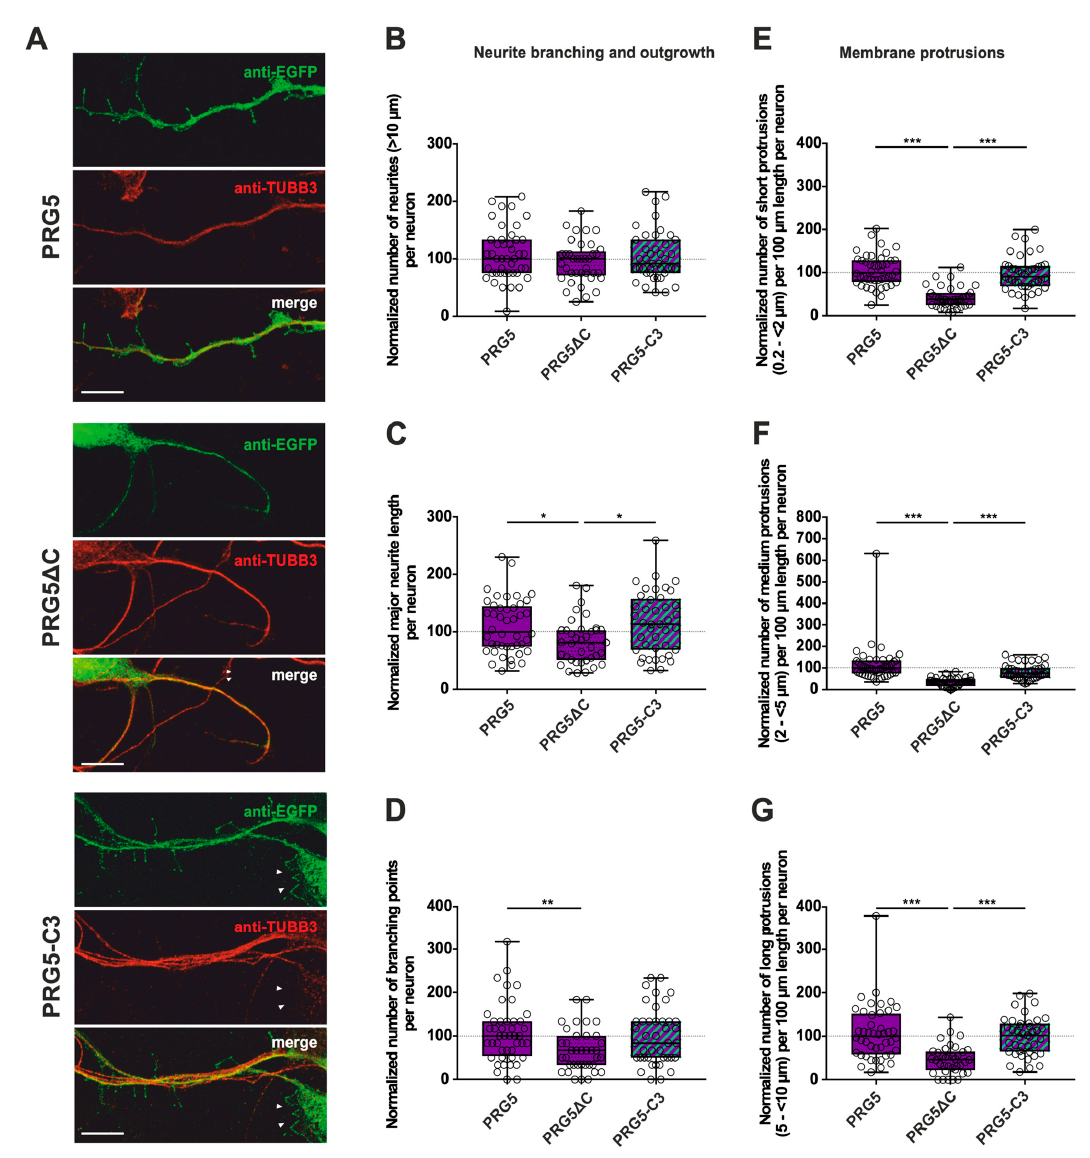
Figure 4. The PRG5 C-terminal domain is an important player in the early development of hippocampal neurons. Subcellular distribution of PRG5-, PRG5 ∆ C- and PRG5-C3-encoding fusion proteins in immature, primary hippocampal neurons in culture. Hippocampal neurons in culture were transfected at DIV1 with ( A ) either PRG5- (upper panel), PRG5 ∆ C- (middle panel), or PRG5-C3-encoding plasmids (lower panel), and analyzed at DIV2. Confocal stacks of representative neurons with immunocytochemistry of the respective fusion proteins stained for GFP to visualize the morphology of the cell or tubulin are shown. Arrowheads denote areas showing membrane localization. The scale bar represents 10 µ m. Boxplots showing the quantification of ( B ) the total number of neurites; ( C ) the major neurite length (* p ≤ 0.01); ( D ) the number of branching points (** p ≤ 0.01) in PRG5-, PRG5 ∆ C- and PRG5-C3-overexpressing neurons. Quantification of membrane protrusions in subgroups based on length in the ( E ) group of short protrusions (0.2–<2 µ m), ( F ) medium protrusions (2–<5 µ m) and ( G ) long protrusions (5–<10 µ m). (PRG5 n = 44, PRG5 ∆ C n = 37, PRG5-C3 n = 41 neurons; *** p ≤ 0.0001). All data are presented as median and IQR. Boxes range from 1st to 3rd quartile. Horizontal lines represent medians. Whiskers represent minimum and maximum. Dots represent the values of individual neurons. Statistical analysis was performed using the Kruskal–Wallis test. A level of confidence of p ≤ 0.05 was adopted (* p ≤ 0.05, ** p ≤ 0.01, *** p ≤ 0.001). PRG5 was always set to 100 and the ratios of changes of the different morphology analyses are shown ( B – G